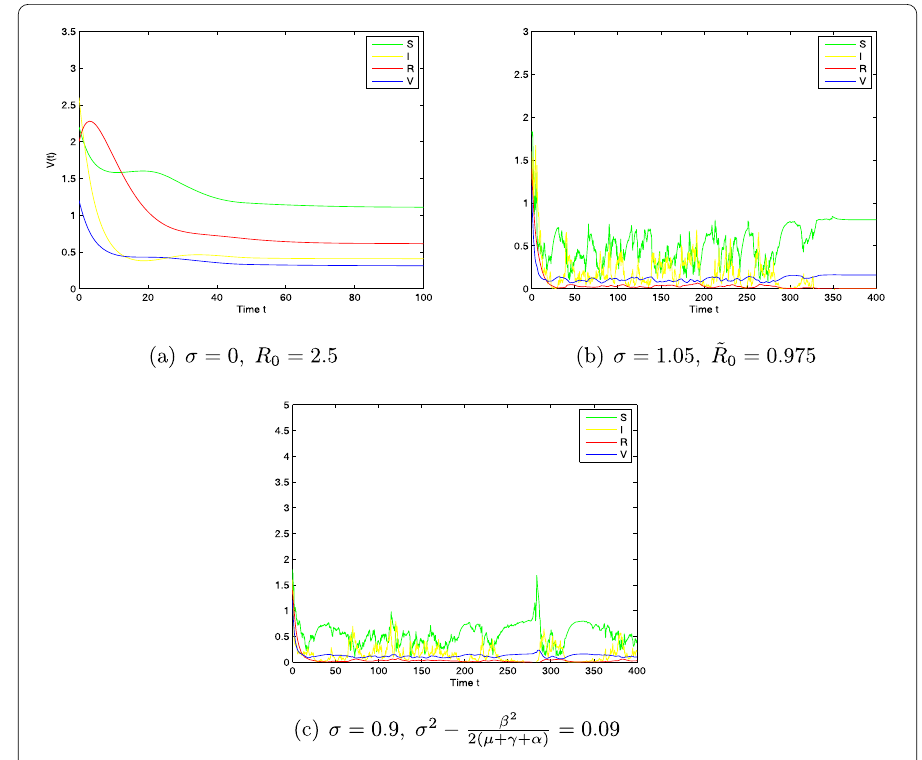
Figure 1 Simulation for paths S ( t ), I ( t ), R ( t ), and V ( t ) for the stochastic system and the corresponding deterministic system with initial value ( S (0), I (0), R (0), V (0)) = (0.5,0.06,0.5,0.5) and step size (cid:26) t = 0.001